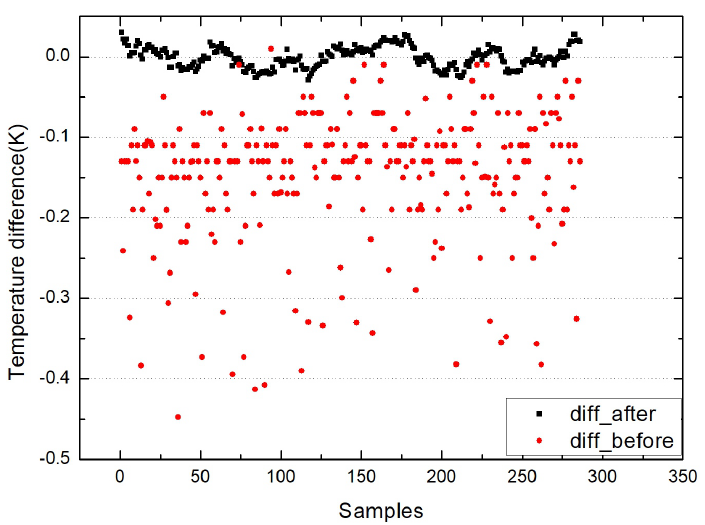
Figure 7. Deviation of the MLX90614 infrared thermometer before correction (diff_before) and the deviation after correction